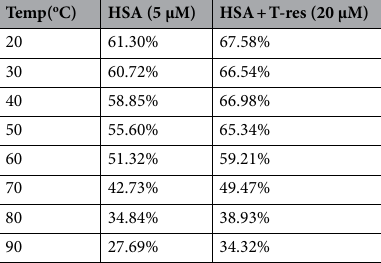
Temp( o C) HSA (5 µM) HSA + T-res (20